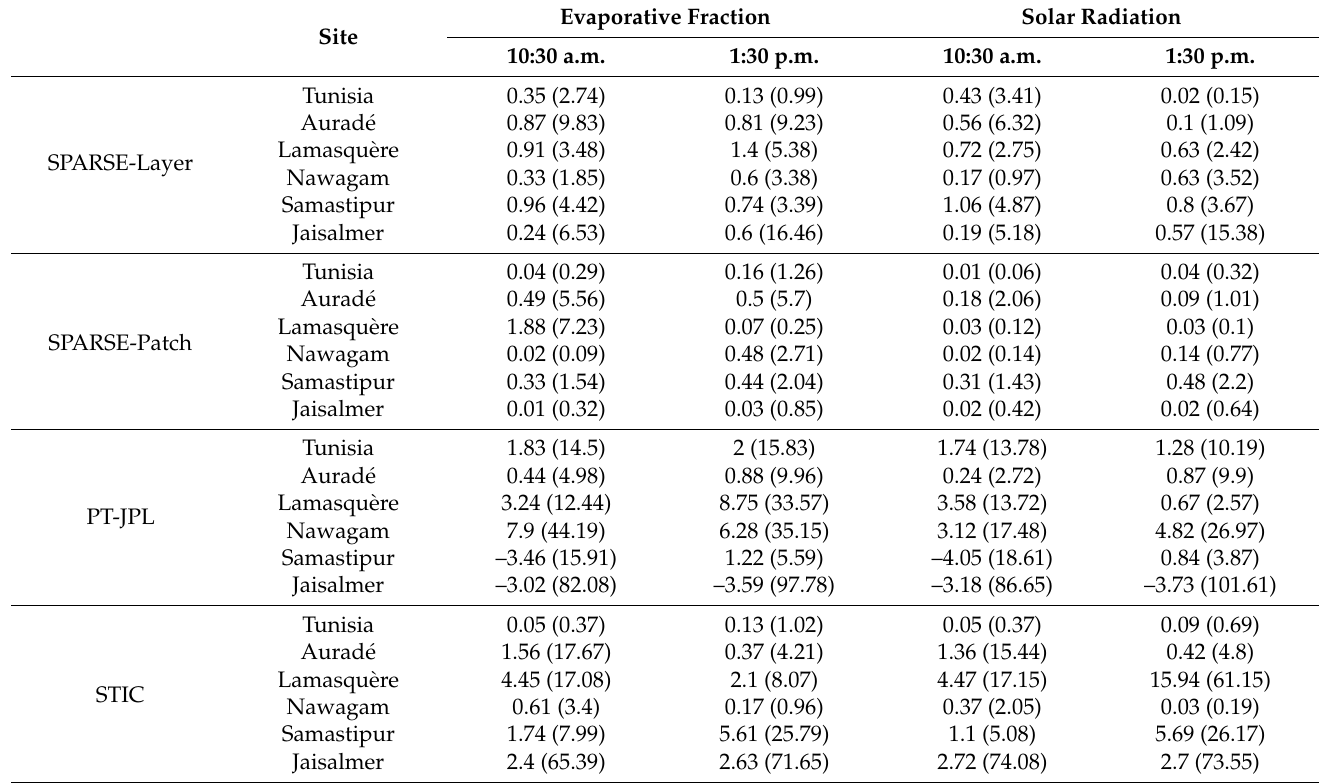
Table 3. Same as Table 2 but for weekly ET values. RMSE differences are expressed in